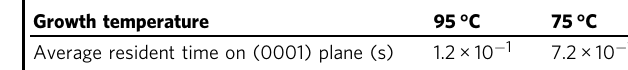
Table 3 The average surface resident time of WO 4 2 − ion on (0001) plane at 75 and 95 °C, estimated from the Frenkel equation using a typical molecular vibrational period 1.0 × 10 − 13